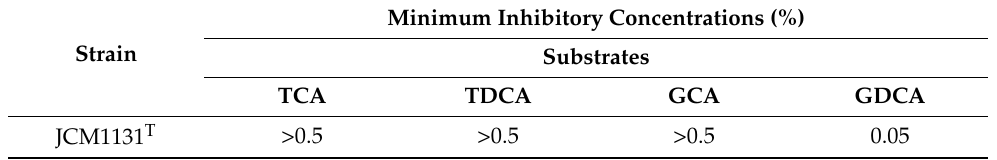
Table 1. Minimum inhibitory concentrations of bile salts against strain JCM1131 T a . Minimum Inhibitory Concentrations (%) Strain Substrates TCA TDCA GCA GDCA JCM1131 T >0.5 >0.5 >0.5